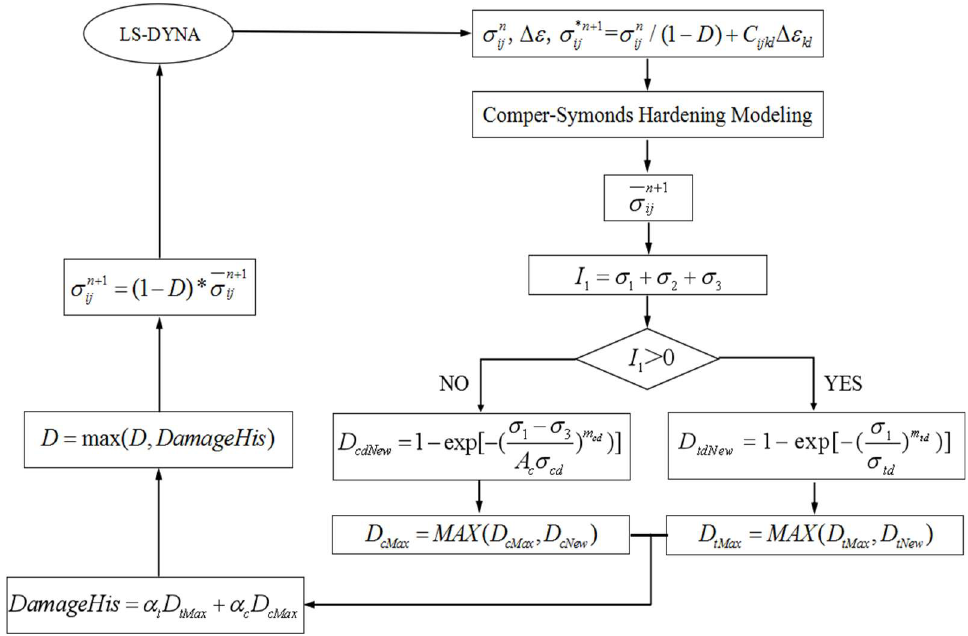
Figure 1. Coupling between Cowper–Symonds hardening model and proposed damage model. In Figure 1, Step 1 Calculate the effective stress tensor σ n